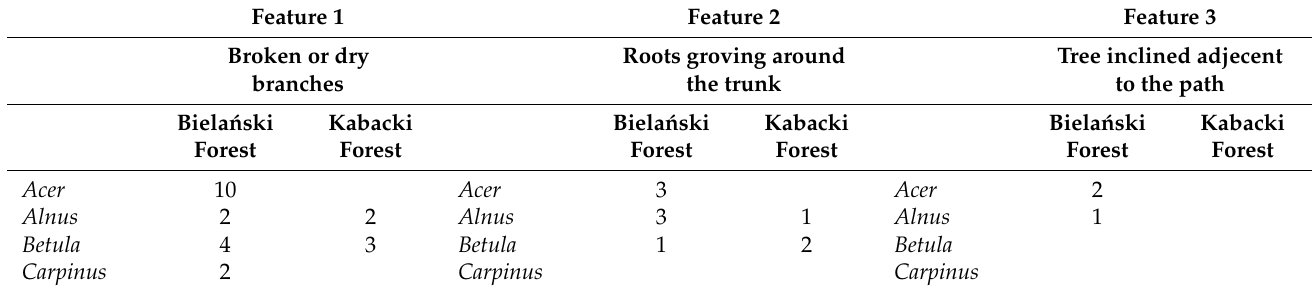
Table A1. Selected defoliated trees of poor health condition (features 1–6) in the Biela´nski Forest and the Kabacki Forest in Warsaw